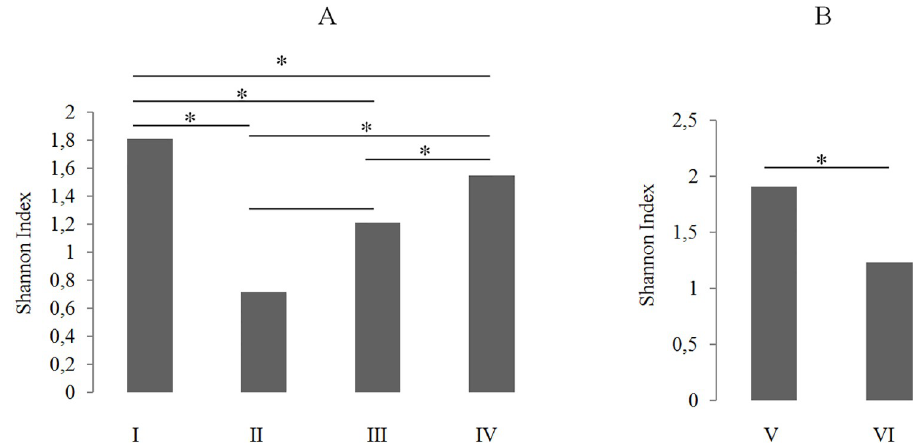
Fig 2. Diversity indexes estimated for the horizontal strata of anthropized environment (A) and for the vertical strata of the wild environment (B). I: peridomicile; II: extradomicile; III: forest edge; IV: forest; V: ground level; VI: canopy level; ( � ): p <